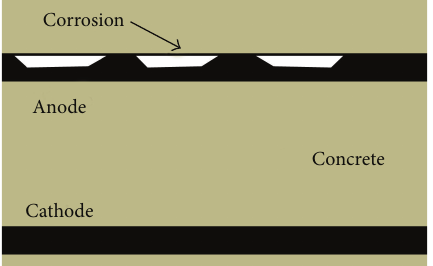
Figure 3: Intended action of discrete anode GCP in mitigating patch-accelerated